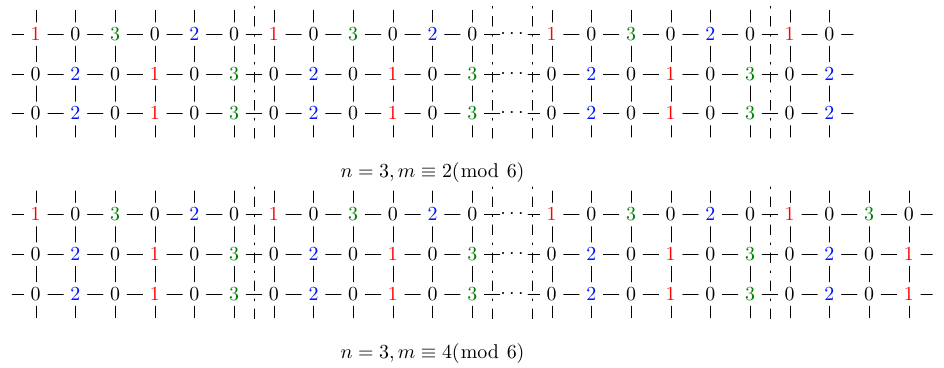
Figure 13. Graph of f in Case 4.2.1